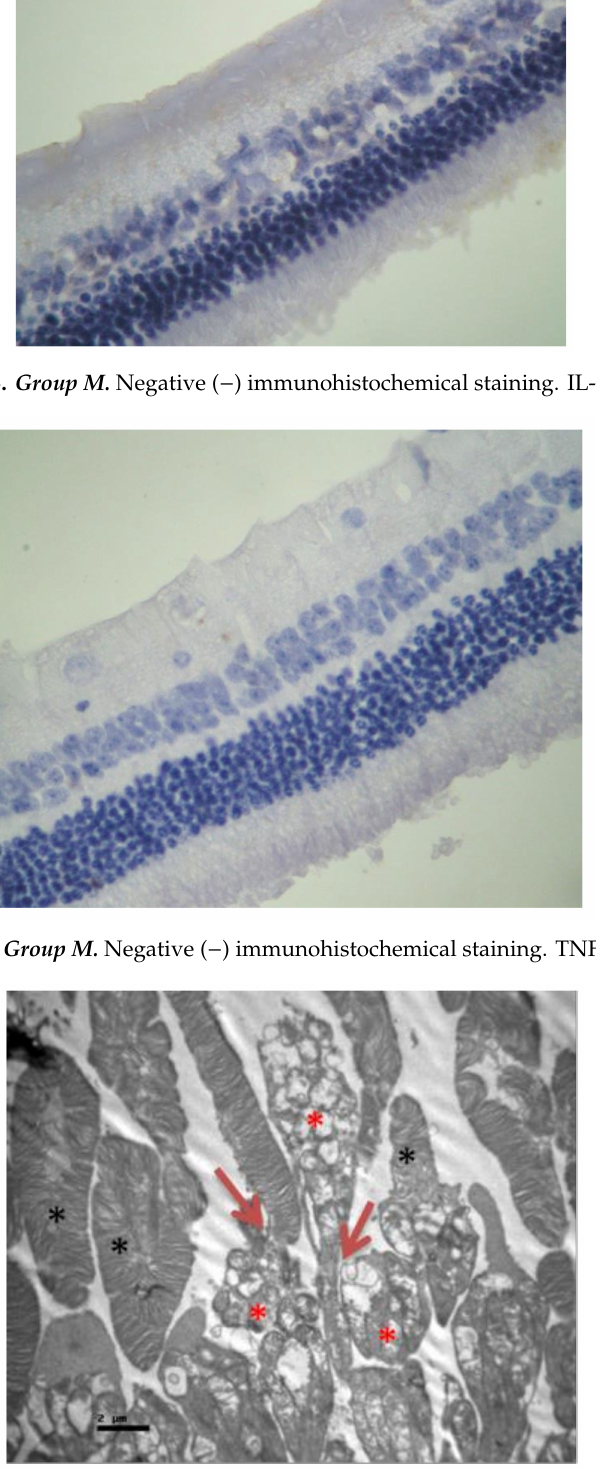
Figure 15. Group M. Separation between the outer and inner segment and absence of the connecting cilium of the photoreceptors. ( ↑ ) In the outer segment, the membranes are separated in the middle leaving a gap and are not parallel to each other. (*) Enlarged mitochondria in the inner segment with minimal folds